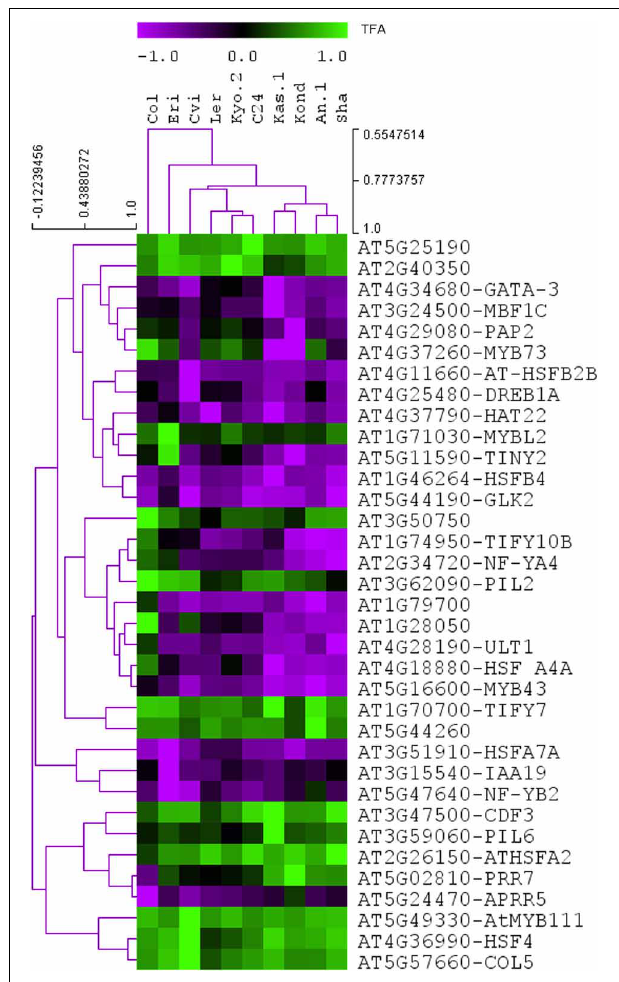
FIGURE 4 | Predicted the activities of the 35TFs among the 10 ecotypes. The NCA algorithm predicts the activities of the TFs based on differential expression profiles (log2 fold change values) of their linked TGs. The predicted activity profiles of the 35 heat regulated TFs shows variations in the 10 A. thaliana ecotypes.